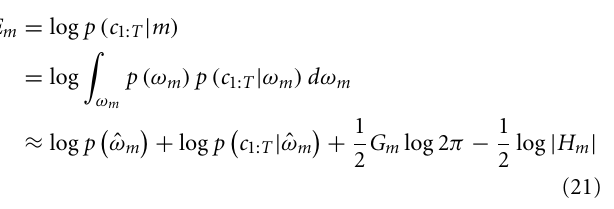
a change and trials 16–20 after a change for each individual subject.The dashed black line corresponds to equality such that subjects lying above this line improved their performance over the course of a block. The two subjects that did not meet this criterion are shown in